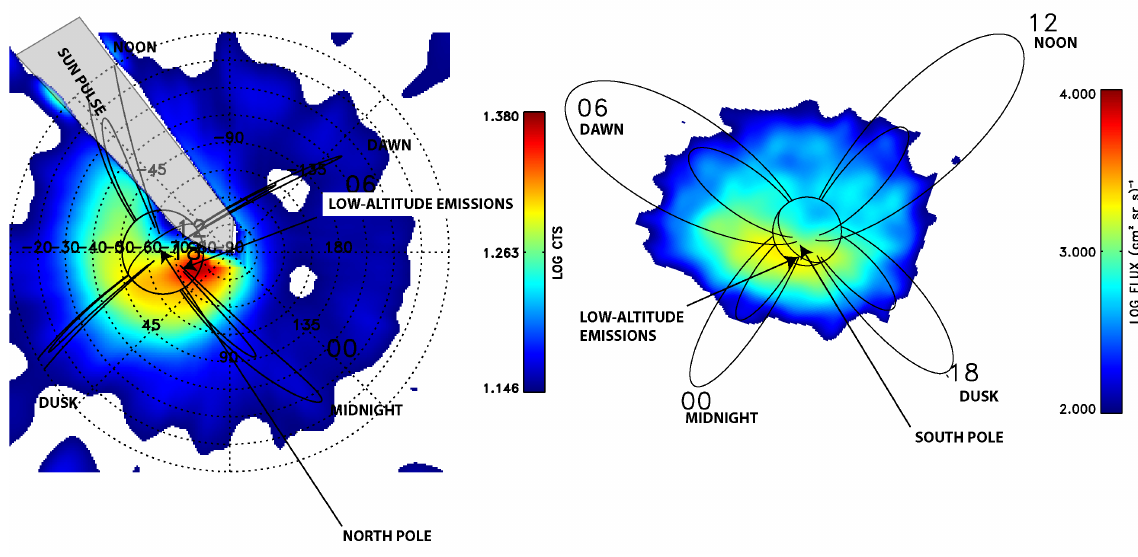
Fig. 23. (Left) ENA image obtained by NUADU/TC-2 in the 81–158keV range from 10:10–11:03 UT on 8 November 2004. Note that this image was taken over the North Pole; (right) ENA image obtained simultaneously by HENA/IMAGE in the 60–119keV range taken over the South Pole. In both images, the ring current can be seen extending from local midnight through